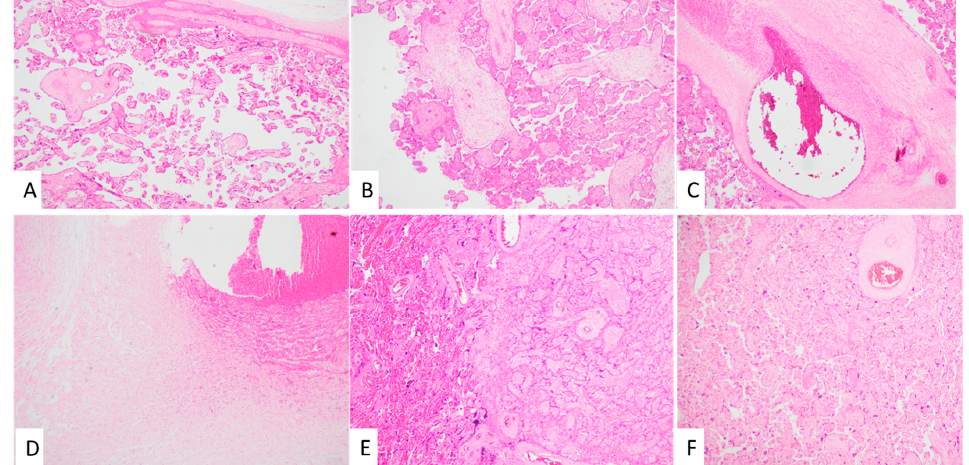
Figure 2. Representative photomicrographs (low magnification) of placental pathology seen in SGA infants. ( A ): Accelerated maturation, ( B ): chronic villitis, ( C ): fetal thromobotic vasculopathy, ( D ): funisitis, ( E ): placental infarct and ( F ): villous crowding, perivillous fibrin.